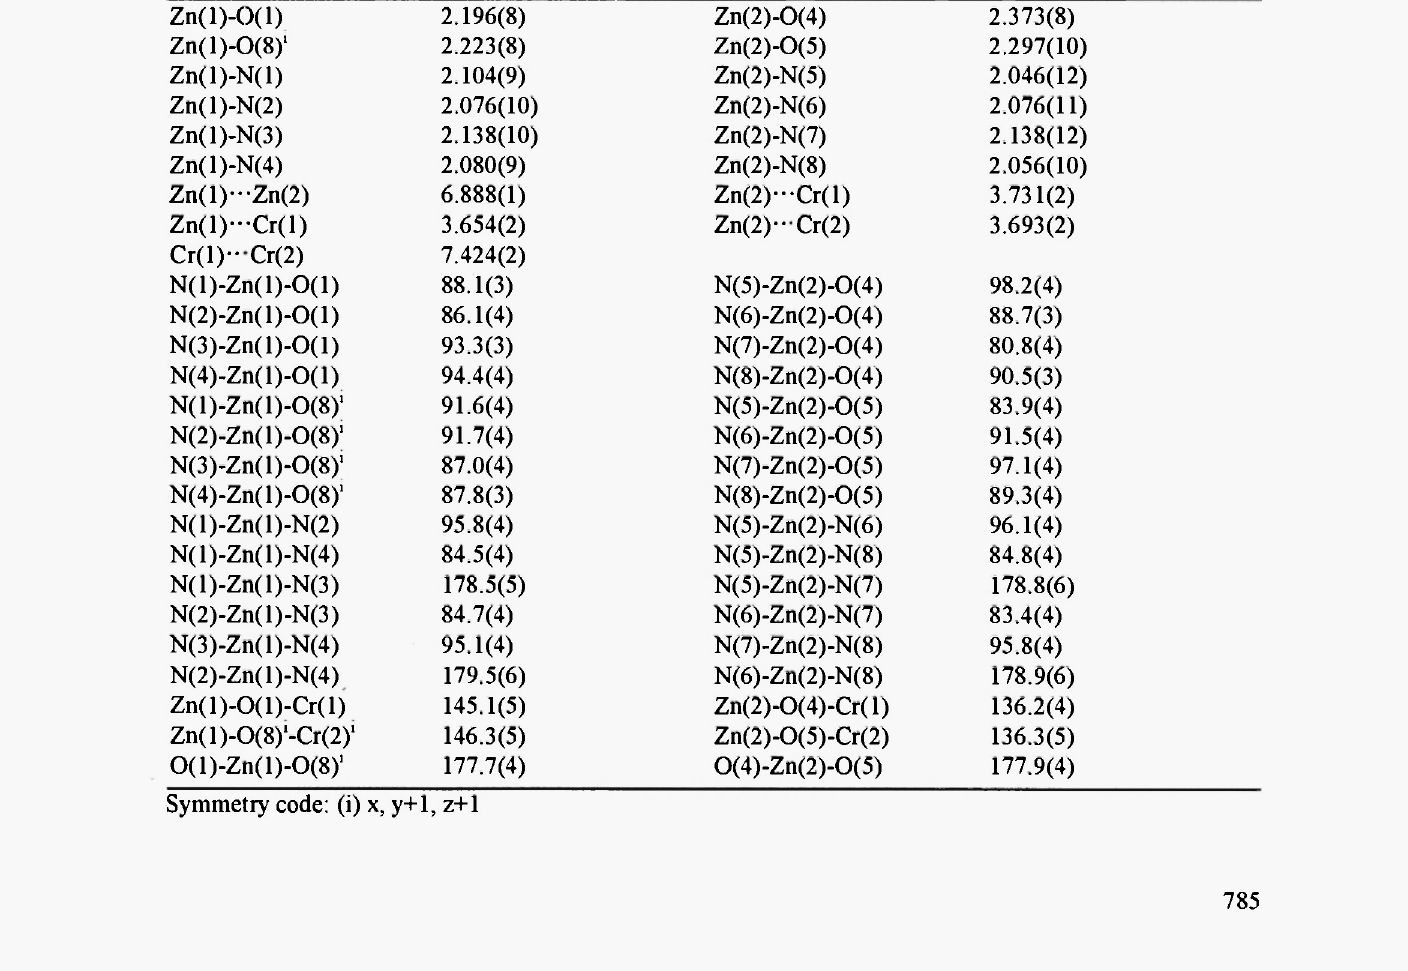
Table 2. Selected bond distances (Ä) and anglesQ for catena-^-Cr04-0,0')[Zn(L)]-10H 2 0